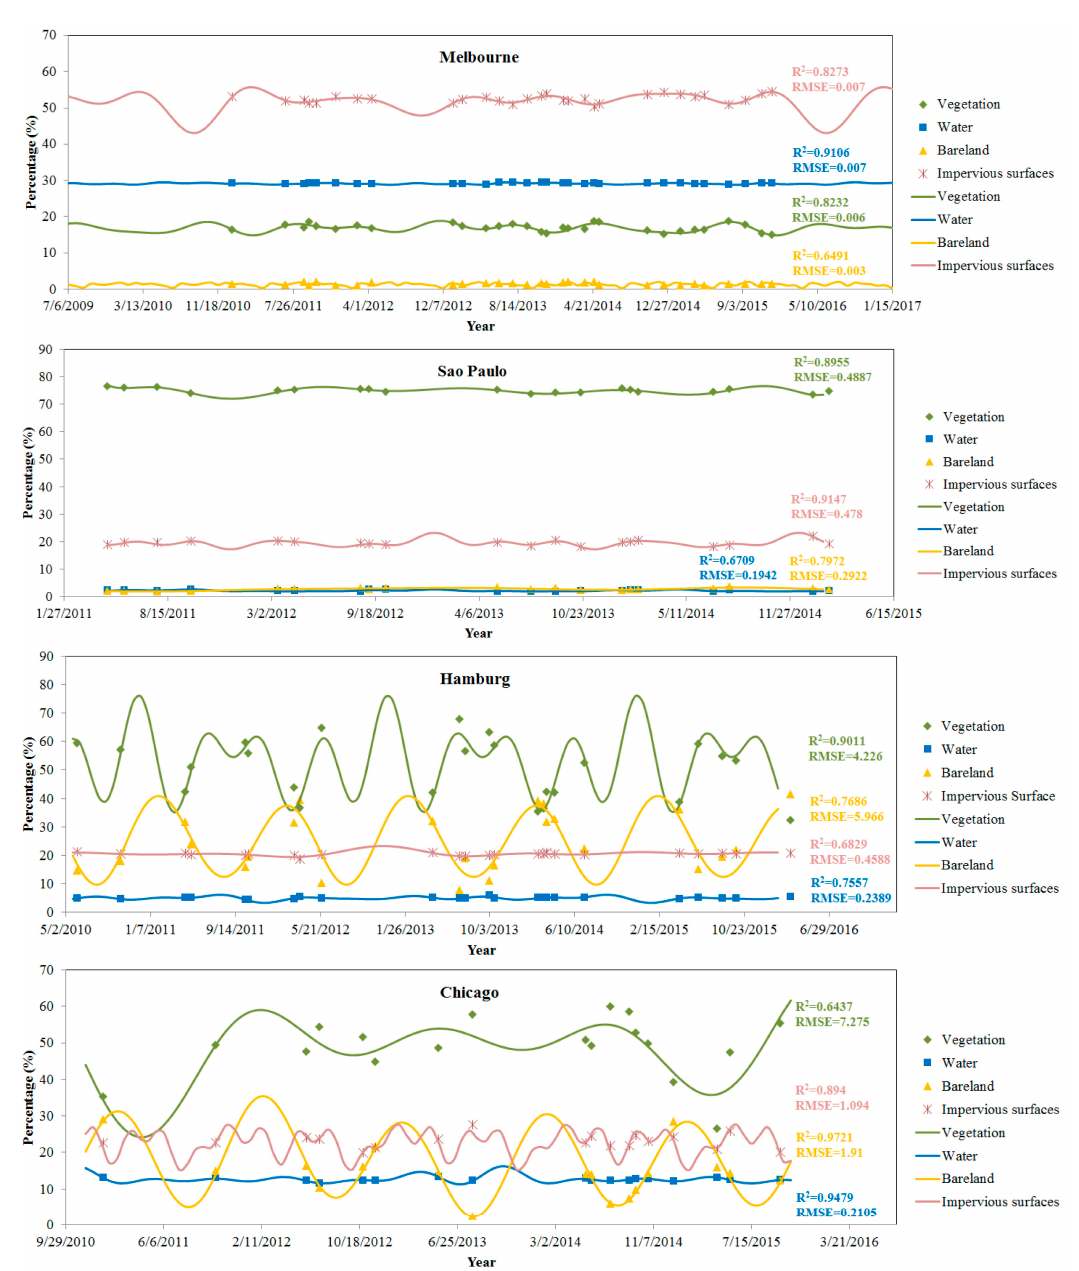
Figure 6. Temporal variations of different urban land cover types fitted using Fourier series.